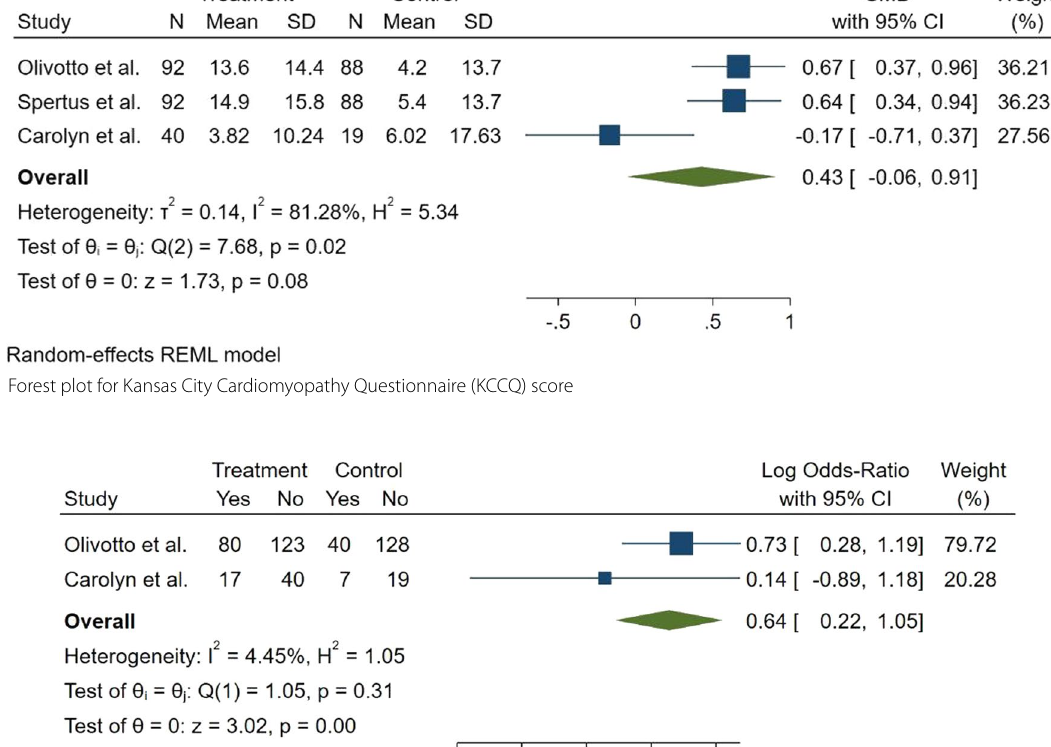
Fig. 3 Forest plot for the number of patients with